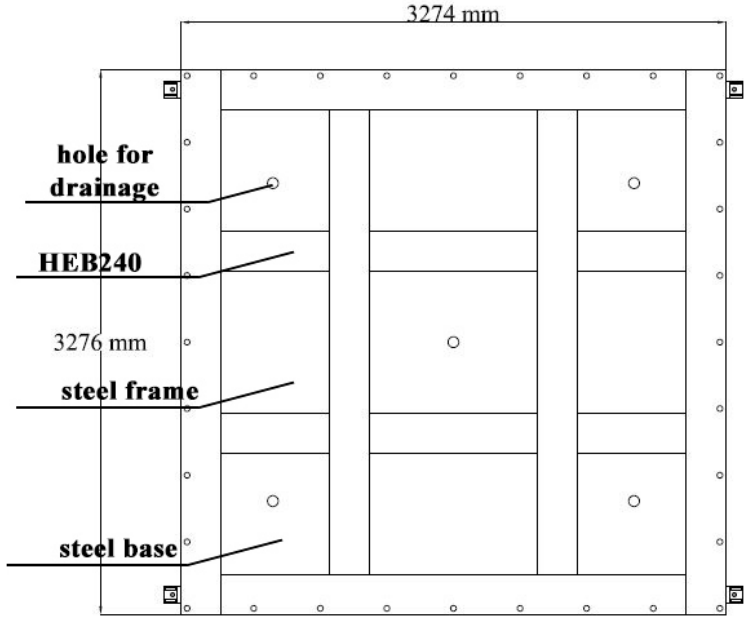
Figure 20. Plan view of the steel frame.